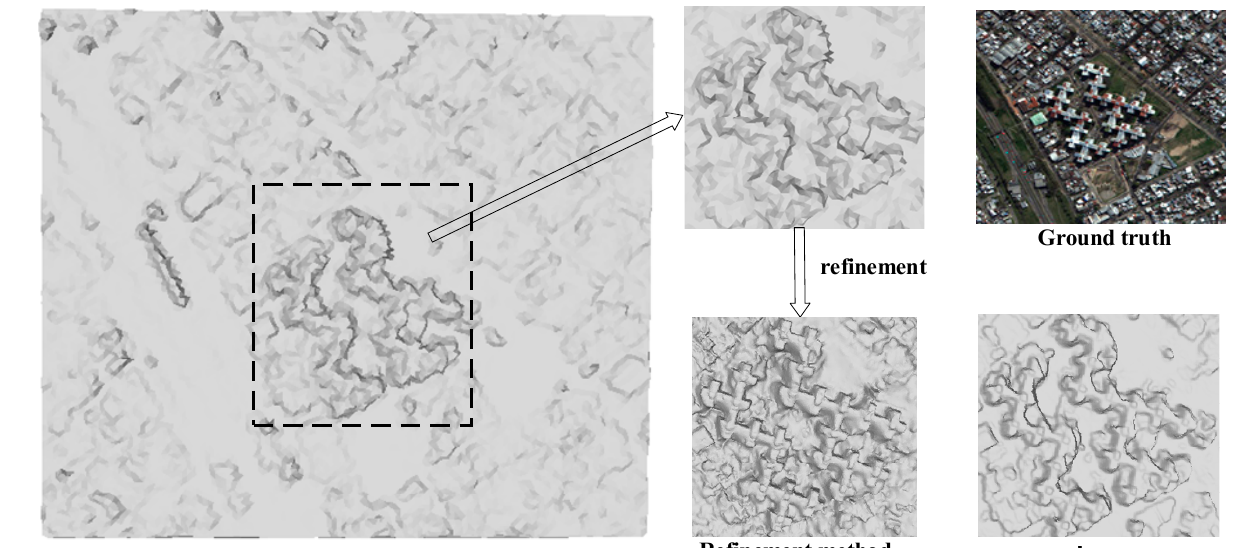
Figure 12. Local details of refinement and the PCI result (test site 1).